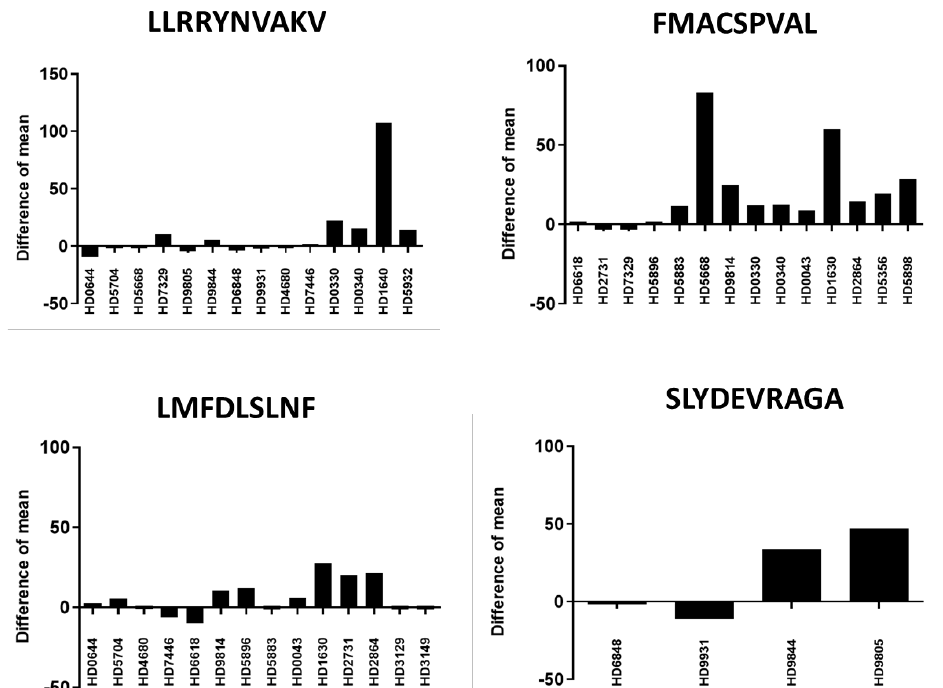
Figure 5. IFN- γ ELISPOT assay showing the peptide-specific activation of T cells. Cells were evaluated in triplicate for each ELISPOT assay, and means were calculated. This figure shows the net mean ELISPOT counts reduced by mean background spot numbers for four different peptides.